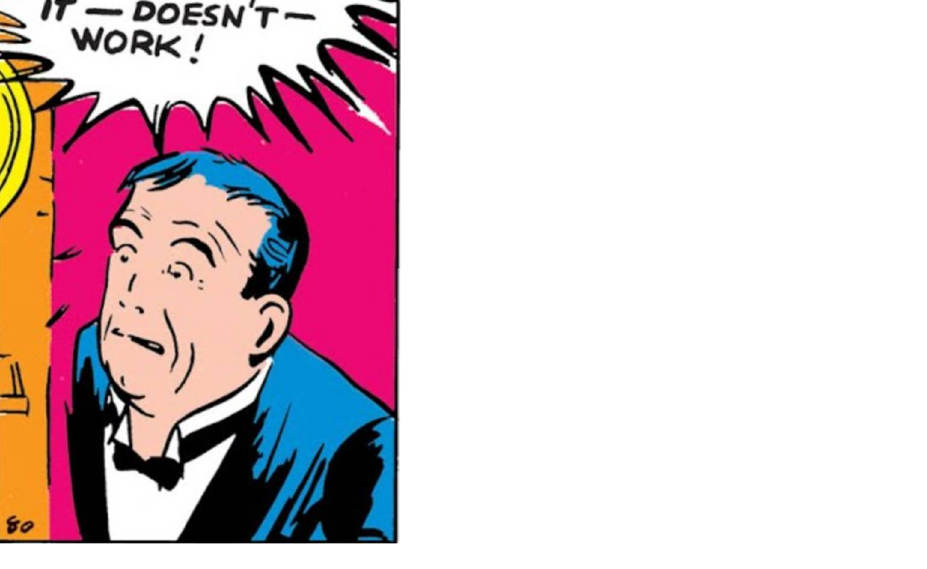
Figure 14. Joe Shuster, Close-Up of a Surprised Man (panel No. 80), 1938. Siegel and Shuster (August 1938), “Superman”, Action Comics #3 (Siegel and Shuster 1938c, p. 46). © DC Comics.